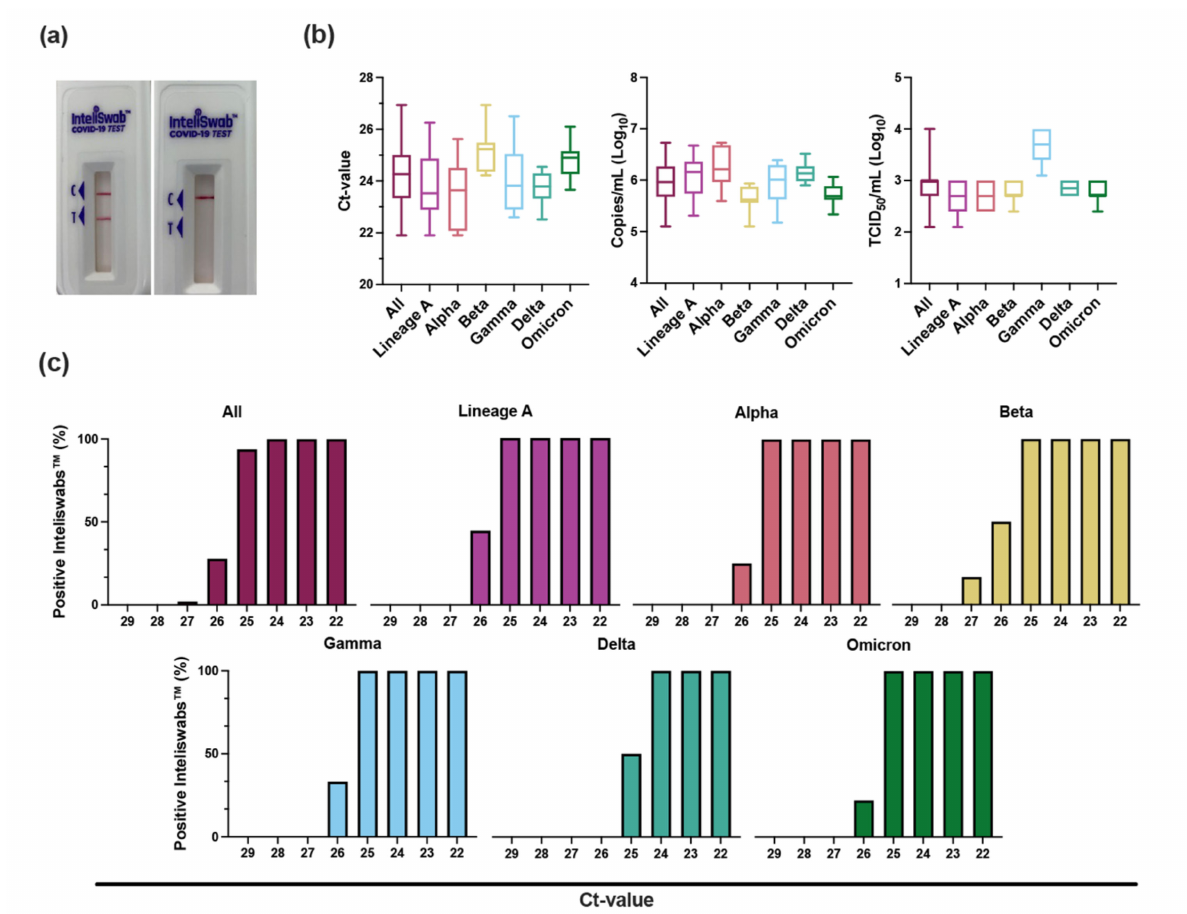
Figure 1. InteliSwab ™ Test detection ability for SARS-CoV-2 variants. Cell culture stocks of the variants were serially diluted, and viral load was measured by gRNA qRT-PCR. ( a ) Comparison of a positive InteliSwab ™ Test (left) and a negative InteliSwab ™ Test (right). ( b ) Box plots displaying the distribution of positive InteliSwab ™ Tests across the 6 variants compared to the Ct values, RNA copies/mL, and TCID 50 /mL. The positive InteliSwabs ™ are from the 2-fold dilution series for each variant (from left to right, N = 145, 31, 27, 19, 30, 18, and 20). Shown is the median, minimum, and maximum. ( c ) Bar charts representing the percentage of positive InteliSwab ™ Tests compared to Ct values. Initial Ct values were rounded to the nearest whole